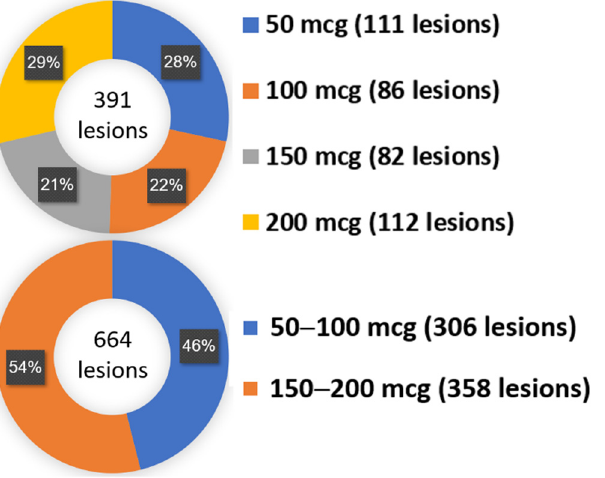
Figure 2. Donut chart summary: in which dose of intracoronary adenosine did the FFR occur? mcg—microgram.